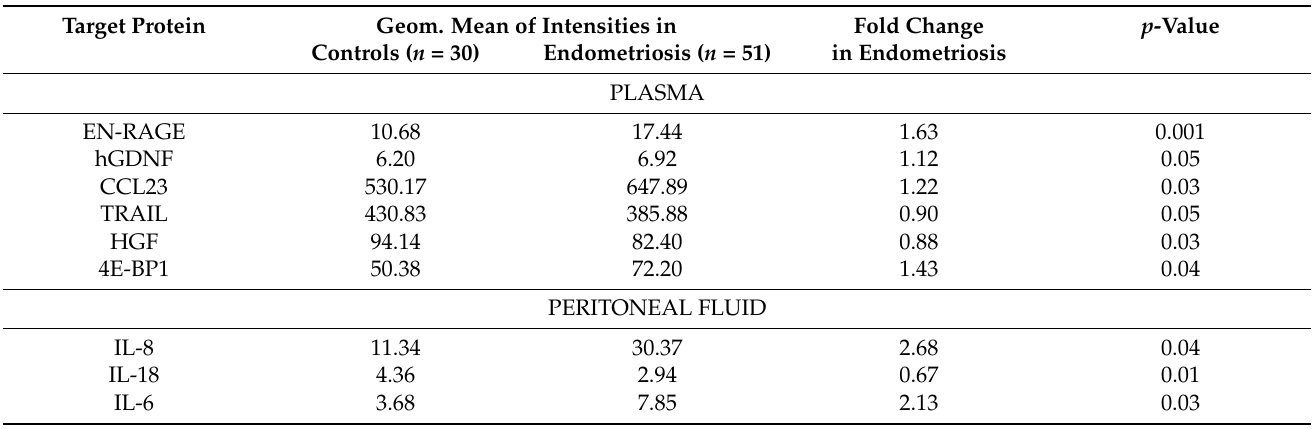
Table 2. Proteins that were significantly increased or decreased in patients with endometriosis compared to controls.